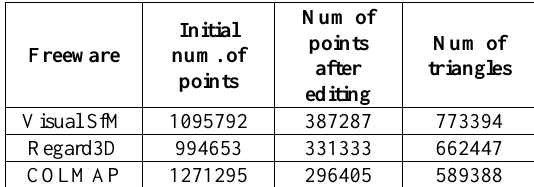
Table 1: Number of points and faces and triangles for each model.